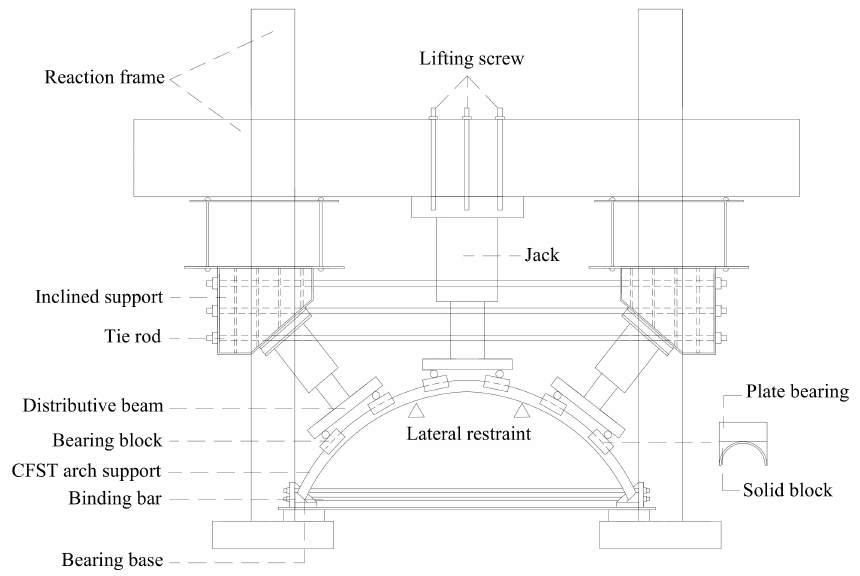
Figure 3. Loading